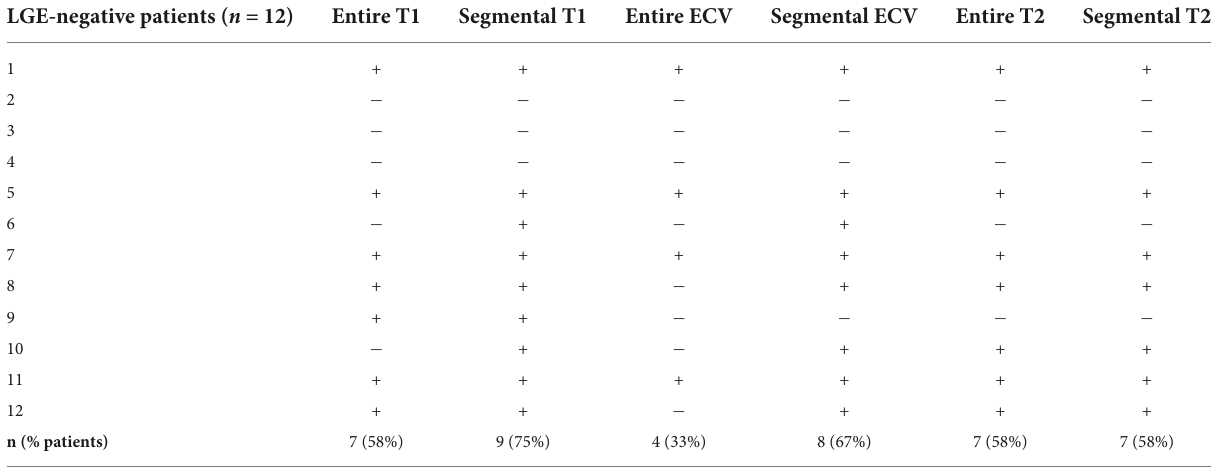
TABLE 3 CMR findings in LGE negative patients: Additional value of mapping. LGE-negative patients ( n =